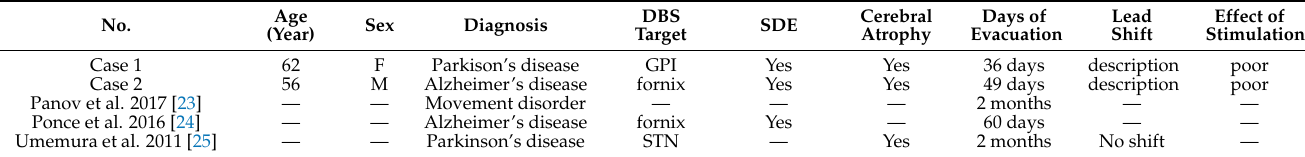
Table 1. The characteristics of the five reported patients with CSDH after DBS